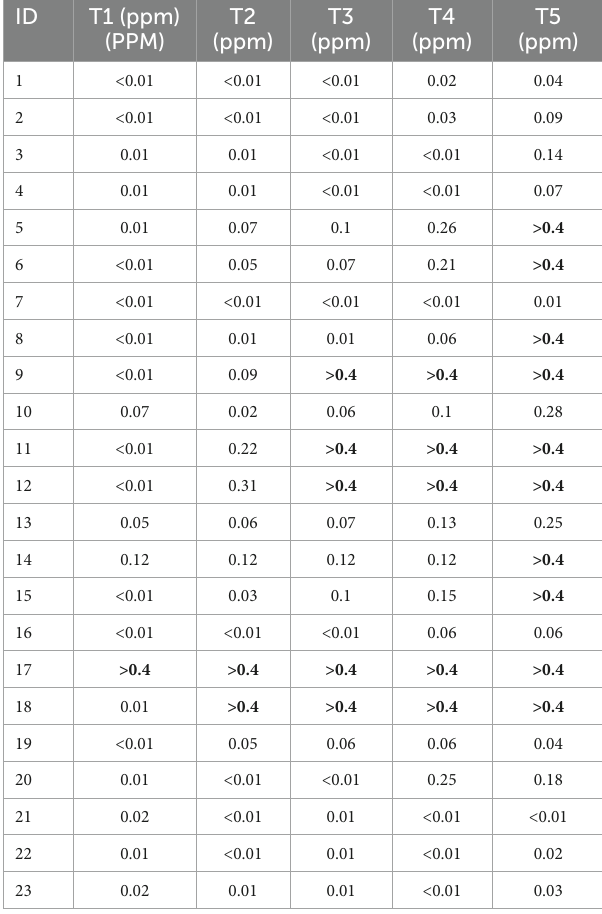
Bold value indicates are measured values but out of the measurement